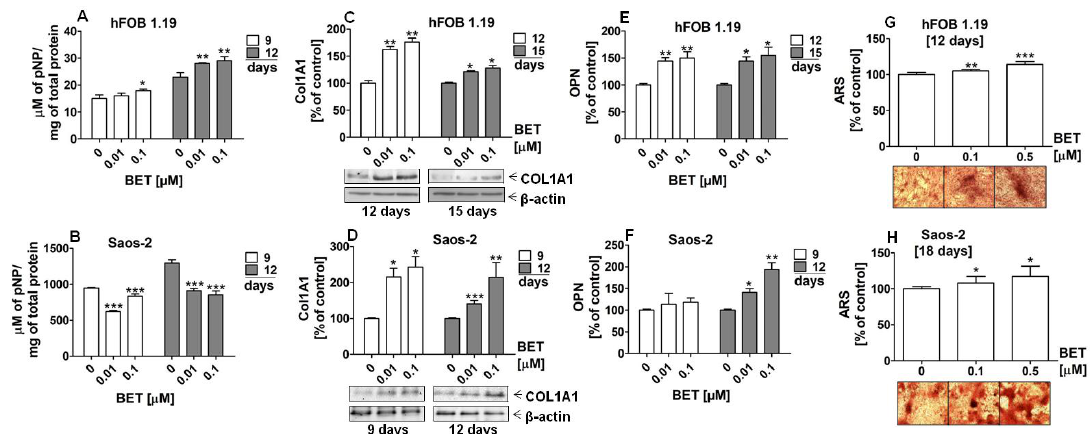
Figure 3. Effect of BET on the production of differentiation markers and the levels of mineralization in osteoblasts after the indicated period of culture in osteogenic conditions. The osteoblasts were cultured in an osteogenic medium supplemented with 0.01, 0.1, or 0.5 µ M of BET or without the compound (control). ALP activity in the hFOB 1.19 ( A ) and Saos-2 cells ( B ) was measured with the colorimetric method. The levels of COL1A1 in the hFOB1.19 ( C ) and Saos-2 ( D ) cells were determined with the western blotting method. The levels of OPN in the culture media from the hFOB 1.19 ( E ) and Saos-2 ( F ) cells were evaluated with the ELISA method. The levels of calcium deposited in the extracellular matrix were determined in 24-well plates using Alizarin Red S staining. Representative micrographs (40×) of stained osteoblast cultures and mean levels of ARS extracted from the hFOB 1.19 ( G ) and Saos-2 cultures ( H ). Mean ± SD from three independent experiments; * p < 0.05, ** p < 0.01, *** p < 0.001 in comparison to the control, one-way ANOVA with post hoc Dunnett’s test.